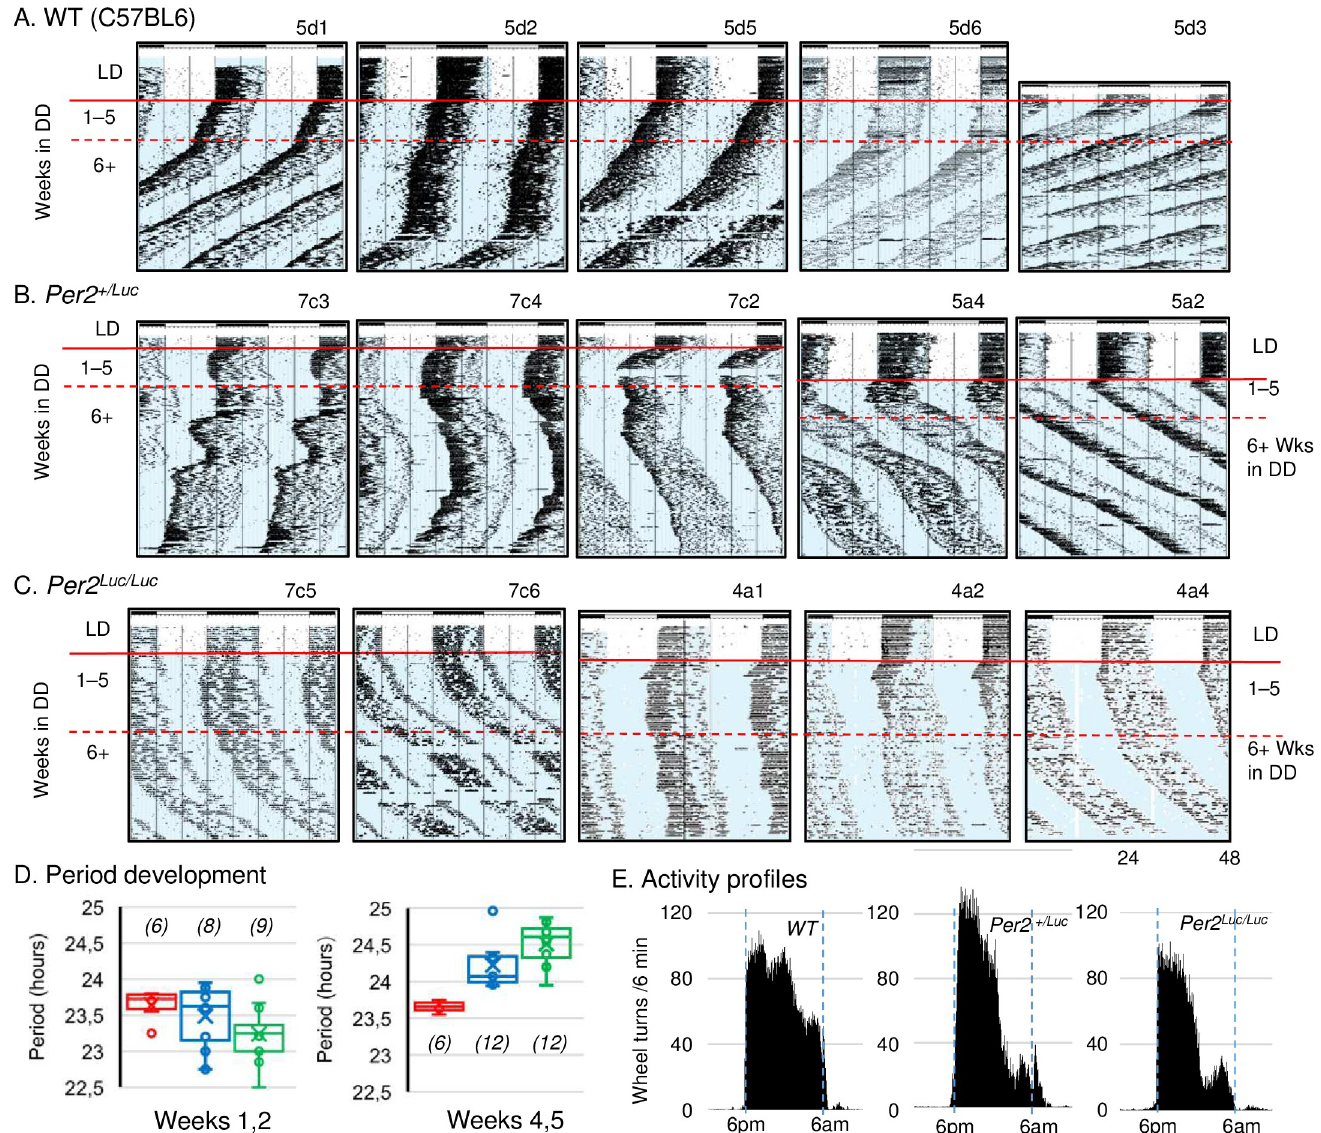
Fig 2. Genotype differences in RWA rhythms in DD. A, B, C. Representative long term records of activity from several experiments from WT C57BL6, mPer2 + /Luc , and mPer2 Luc/Luc mice, respectively. All animals were entrained to LD12:12 prior release into DD. WT animals (A) show the expected range of periods ( < 24 h in DD). Homozygous mPer2 Luc/Luc mice (C) exhibit long period ( > 24 h in DD); and heterozygous Per2 +/Luc mice (B) exhibit individual variance with patterns ranging between the wild type and mutant characteristics, as well as period instability over time in DD. D. Average periods of the 3 genotypes over the 4–10 days following transition from LD to DD (left) and days 25–35 in DD (right). Cumulative data from several experiments. N/group is shown in parentheses all other comparisons = ns . The region analyzed is indicated by horizontal red lines on the actograms. E. Activity profiles for WT, mPer2 +/Luc and mPer2 Luc/Luc mice in LD12:12. Dark half of the cycle is indicated by blue rectangles with lights off from 6pm to 6 am. The grand average from 6 animals per genotype was produced from individual averages of the last 10 days in LD prior to transfer to constant conditions as illustrated in A, B, C . https://doi.org/10.1371/journal.pcbi.1008987.g002 the three genotypes. Although visual examination of the records indicates an increased bimodal expression of activity in mutants versus WT, quantitative analysis of bimodality per se is not appropriate using RWA in this case (see Discussion). Nonetheless, a 2-way ANOVA comparing activity among the 3 h nighttime quartiles showed main effects of genotype ( F = G 8.127; P = 0.0008) and time ( F = 36.5779; P < 0.00001). Post hoc tests (Scheffe´, multiple t- T tests) indicate a significantly lower amount of activity from mPer2 Luc/Luc mice compared with